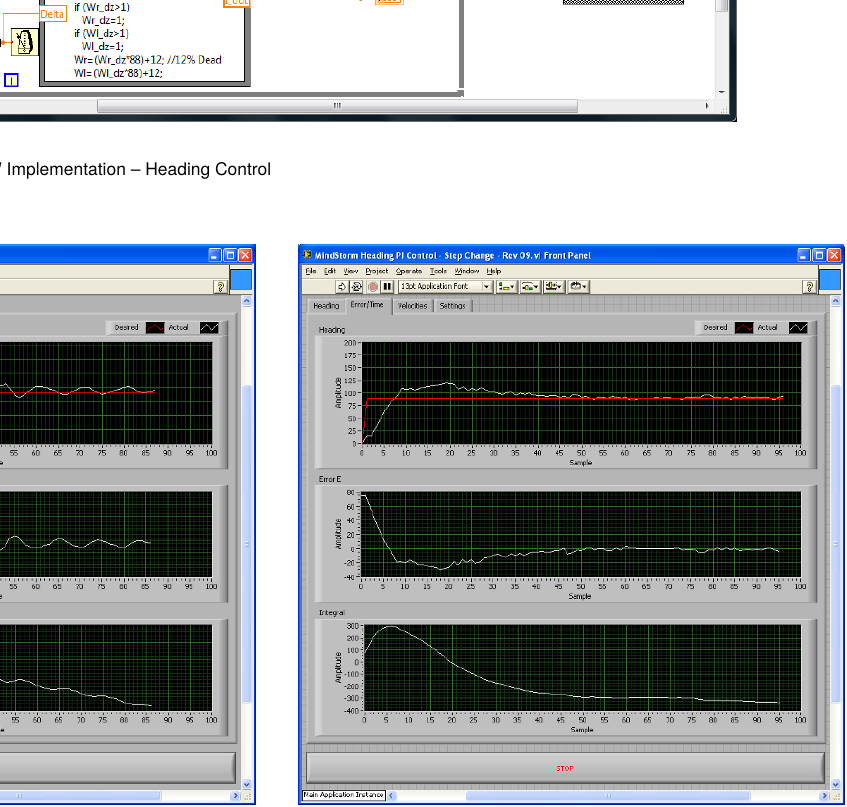
Figure 21. Mindstorm Pose Adjustment Step Responses – Tuned PI